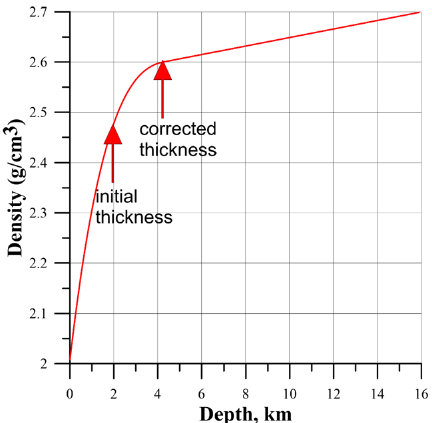
Figure 7. Illustration of the sedimentary thickness correction. This example corresponds to a negative decompensative